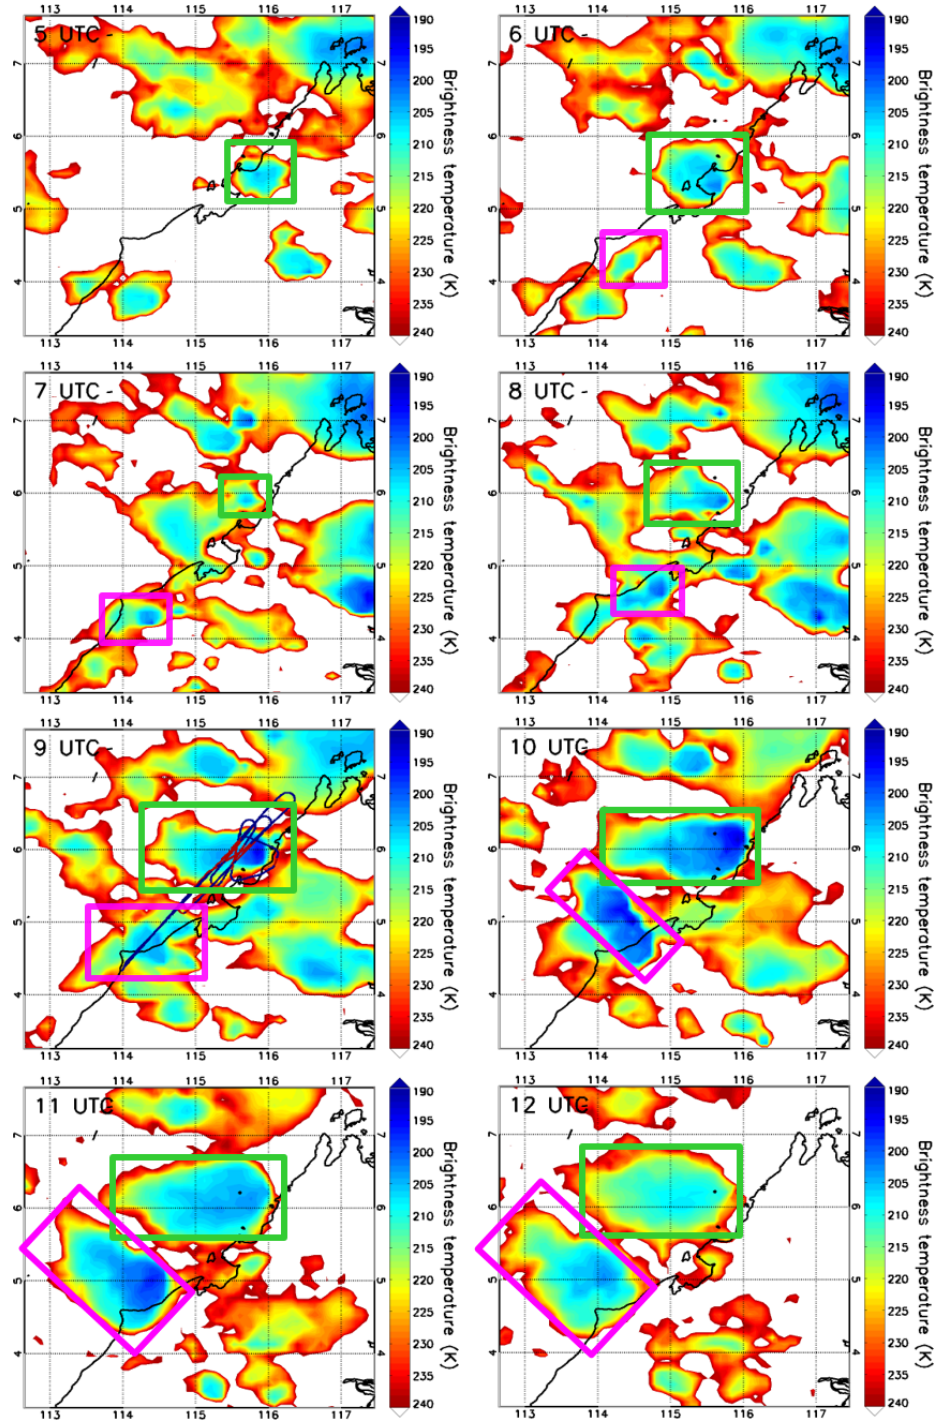
Figure 1. The contours show the brightness temperatures from MTSAT-2 at 05:00UTC, 06:00UTC, 07:00UTC, 08:00UTC, 09:00UTC, 10:00UTC, 11:00UTC, and 12:00UTC on 19 November 2011 (plots are labelled with time in UTC). The system called Obs_Conv1 is shown by a green rectangle and Obs_Conv2 by a pink rectangle. The black line shows the coast with the land to the east. The vertical axis is latitude (degrees north), and the horizontal axis is longitude (degrees east). In the 09:00UTC panel, the Falcon aircraft trajectory on the afternoon of 19 November 2011 is overplotted. The red crosses indicate the location where the aircraft crossed convective outflows as determined in Krysztofiak et al.